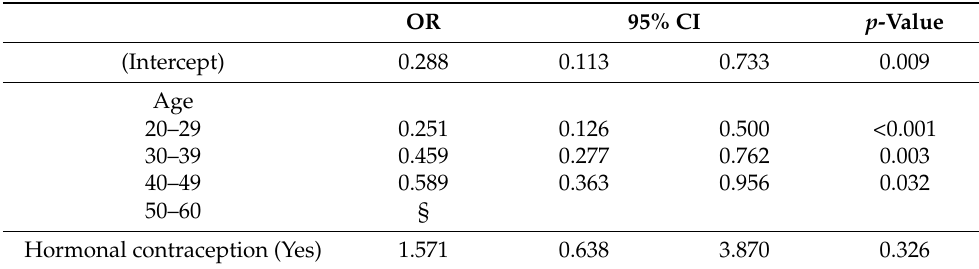
Table 3. Vaccination regimen chosen by age and hormonal contraception (women): generalized linear model.